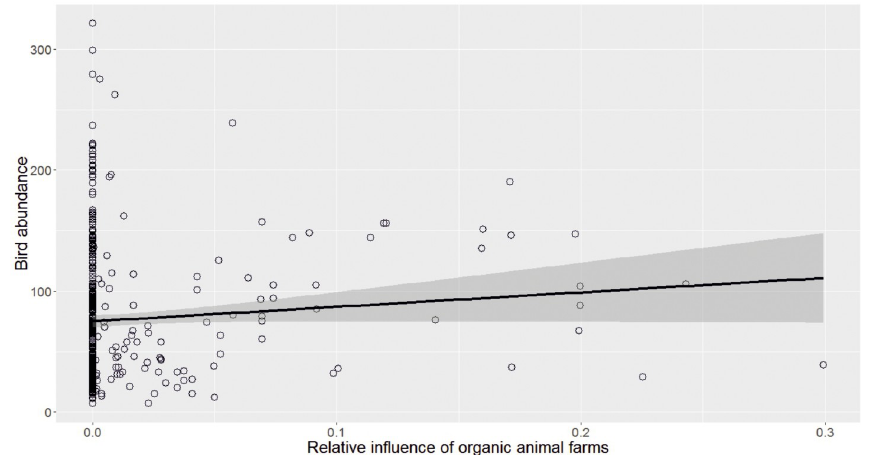
Fig 2. Effects of organic animal farms on overall bird abundance. The positive relationship between the relative influence of organic animal farms (averaged within a 300m radius from each transect line) and summed bird abundance across South and Central Finland between 2008 and 2013 based on the original untransformed data.